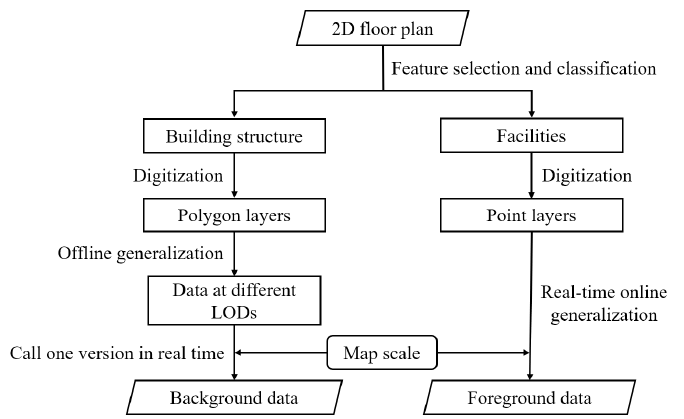
Figure 2. General workflow of indoor map data generalization. LODs, levels of detail.